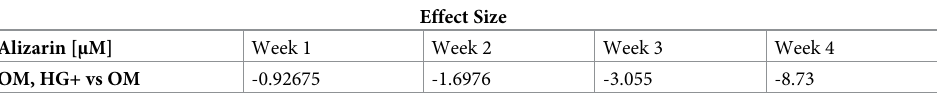
Table 1. The magnitude of effect size increased with time as MC3T3_E1 cells were treated with high glucose dur- ing